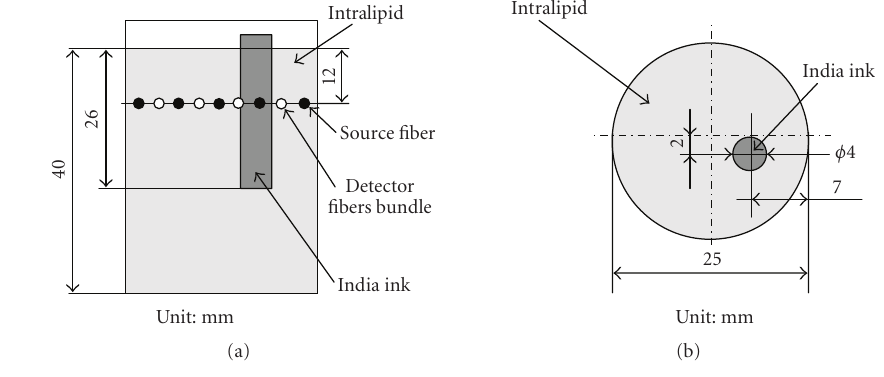
Figure 6: Data acquisition and signal processing GUI.